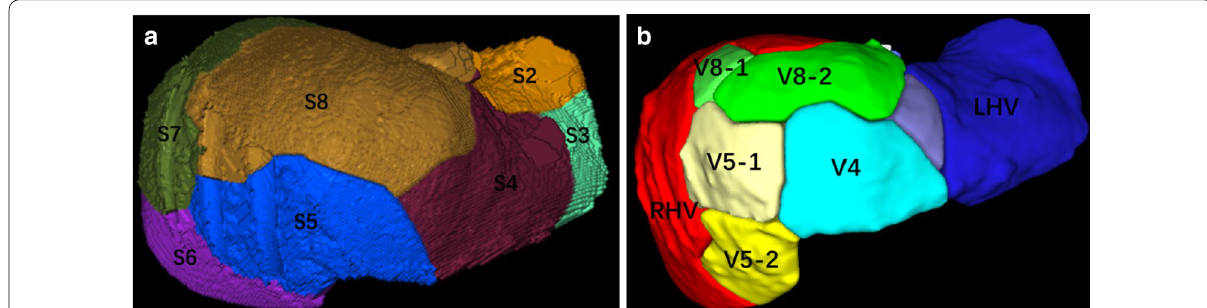
Fig. 5 Three-dimensional reconstruction of the liver segments: a shows the area dominated by portal vein branch: S2: 99 mL (5.9%), S3: 74 mL (4.4%), S4: 237 mL (14.2%), S5: 186 mL (11.2%), S6: 182 mL (10.9%), S7: 409 mL (24.5%), S8: 479 mL (28.8%). b Shows the area dominated by hepatic vein branch: RHV: 630 mL (37.8%), LHV: 243 mL (14.6%), V8-1: 108 mL (6.5%), V8-2: 233 mL (14.0%), V5-1: 122 mL (7.3%), V5-2: 140 mL (8.4%), V4: 150 mL (9.0%). S2: segment 2, S3: segment 2, S4: segment 4, S5: segment 5, S6: segment 6, S7: segment 7, S8: segment 8, LHV: left hepatic vein, RHV: right hepatic vein, V4: hepatic vein of segment 4, V5-1: a branch of MHV which drained part one of segment 5, V5-2: a branch of MHV which drained part two of segment 5, V8-1: a branch of MHV which drained part one of segment 8, V8-2: a branch of MHV which drained part two of segment 8. MHV middle hepatic vein